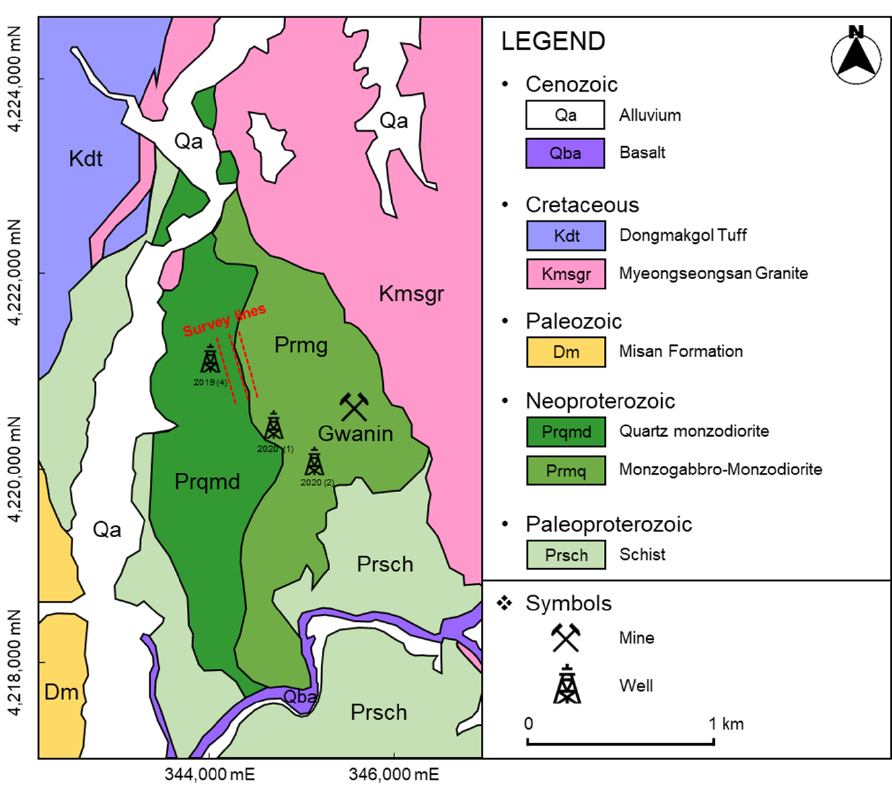
Figure 1. Geological map of the area surrounding the Gonamsan intrusion (modified from Kee et al. [16]). Numbers below the well symbols indicate the installation year and the number of wells. The red dashed lines represent the three parallel lines of the electrical resistivity and induced polarization survey.